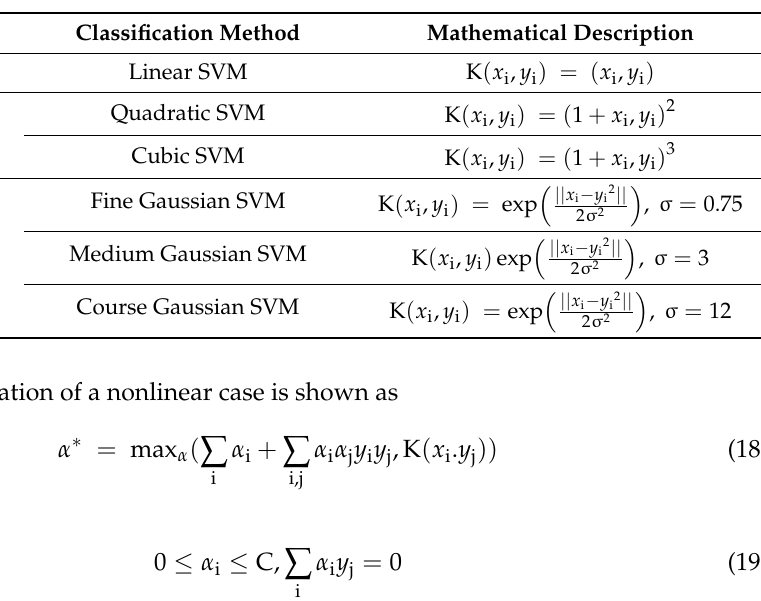
Table 1. SVM kernel